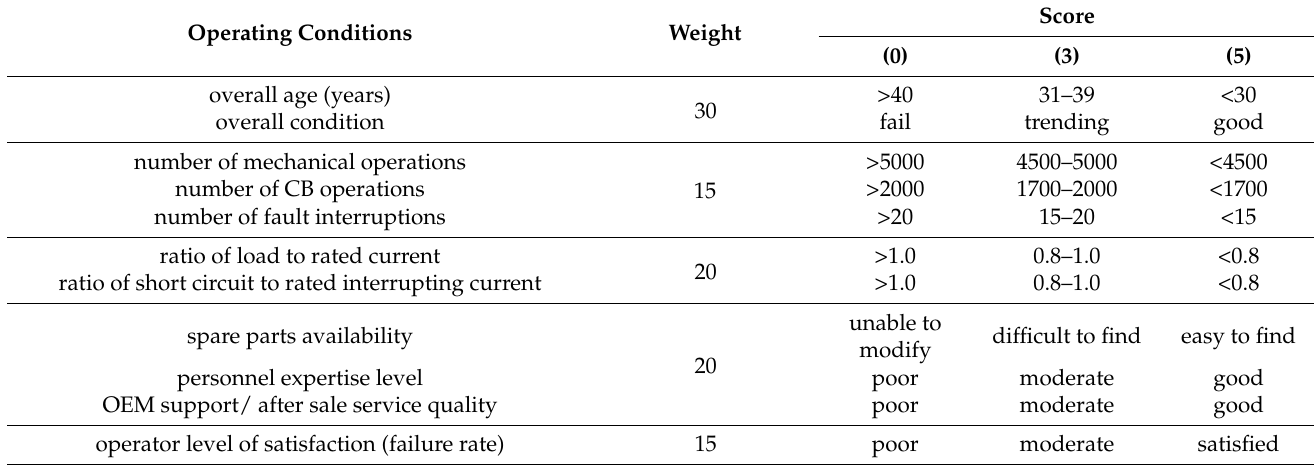
Table 8. Criteria with score and weight for conditional factor